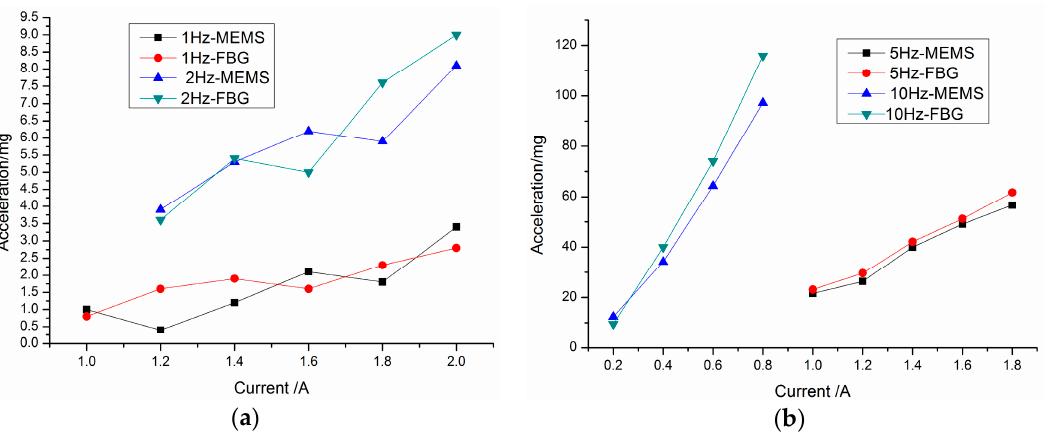
Figure 15. Comparison of the measured acceleration graphs of the two kinds of sensors under different amplitude of current with frequencies of ( a ) 1 Hz and 2 Hz; ( b ) 5 Hz and 10 Hz.